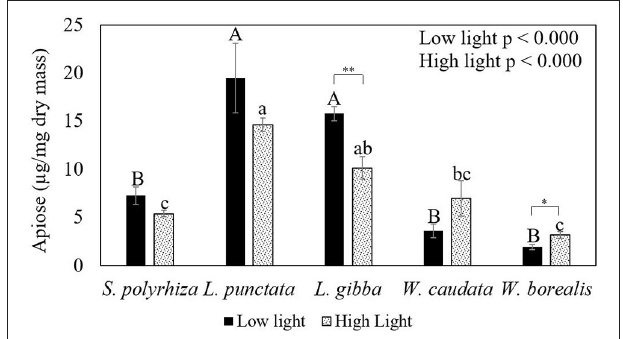
FIGURE 4 | Comparative analysis of the apiose content in the cell walls of duckweeds ( S. polyrhiza, L. punctata, L. gibba, W. caudata , and W. borealis ) cultivated under two light intensity (20 and 500 µ mol photons m − 2 s − 1 ) conditions. Data are the averages ± standard errors ( n = 4). Letters in capital on top of darker bars are the significant differences by Tukey’s test ( p < 0.05) for low light. Lowercase letters on top of gray bars mean significant differences regarding high light. Asterisks indicate significant differences by t -test ( p < 0.05) for species in two light